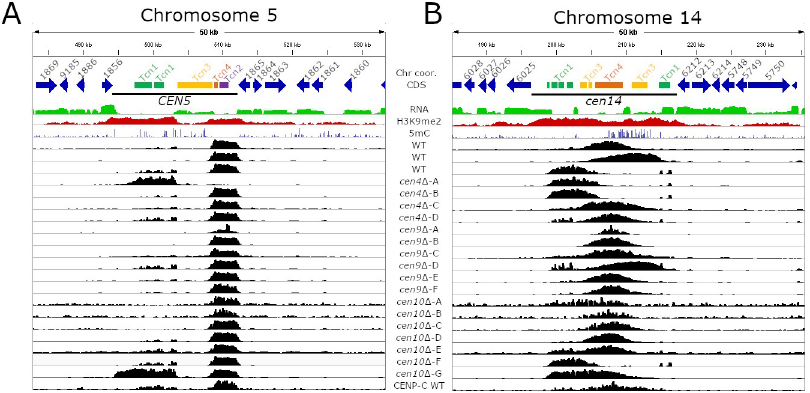
Fig 5. Centromeric drift occurs within ORF-free regions of C . deuterogattii . The top panels of both figures show the chromosomal coordinates, genome annotation, RNA-seq, H3K9me2 ChIP-seq, and 5mC for wild-type. CENP-A ChIP-seq is shown in black and the final panel shows CENP-C ChIP-seq. (A) Centromeric drift in CEN5 is correlated with the presence of a large, but truncated Tcn3 element. This truncated Tcn3 element functions as a barrier and for all isolates with the exception of cen10 Δ -G, CENP-A is present on only one side of the truncated Tcn3 element. (B) Centromere drift occurs in CEN14 and the CENP-A peaks drift within the ORF-free region of CEN14 and lack a defining